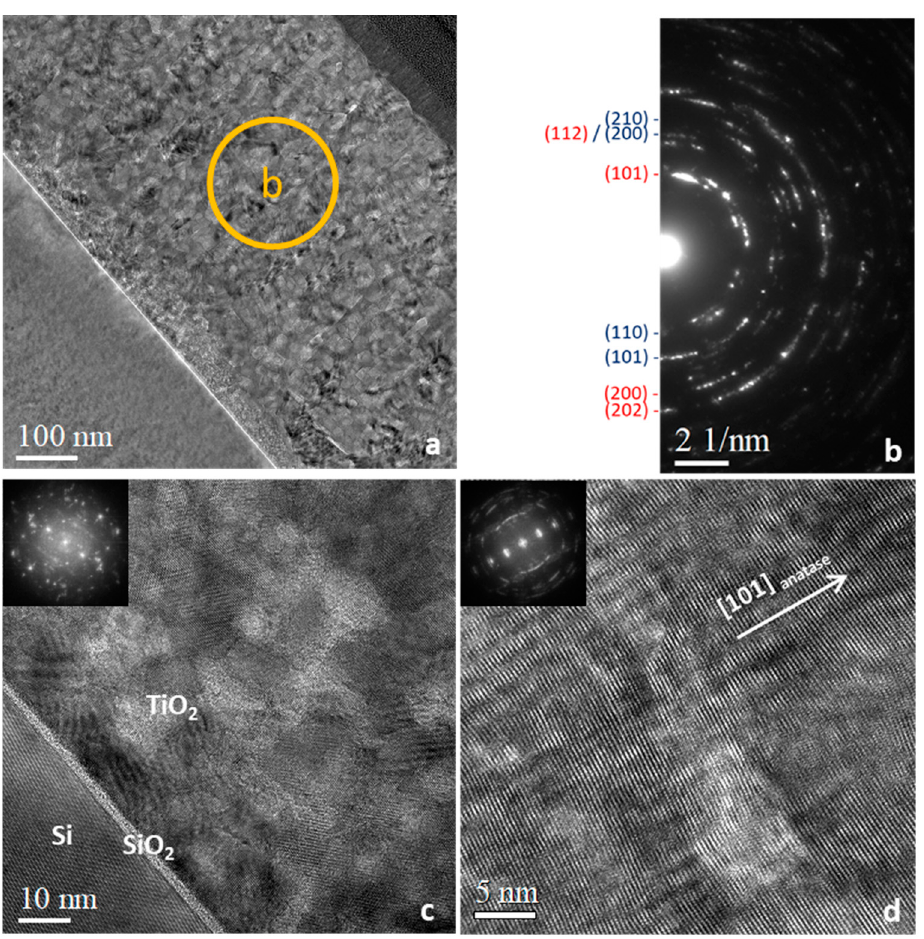
Figure 7. TEM images obtained on the 600 °C-annealed TiO 2 thin film (M7T) ( a ) and corresponding selected area electron diffraction ( b ), HRTEM micrographs near the Si/TiO 2 interface (with visible native SiO 2 ) ( c ) and at the TiO 2 film surface ( d ). The diffraction rings have been labeled with the corresponding lattice planes (hkl) (anatase in red, rutile in dark blue) on ( b ).